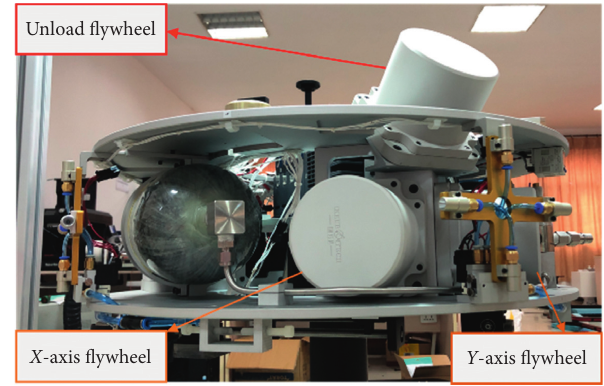
Figure 1: X -axis, Y -axis, and oblique reaction flywheel.